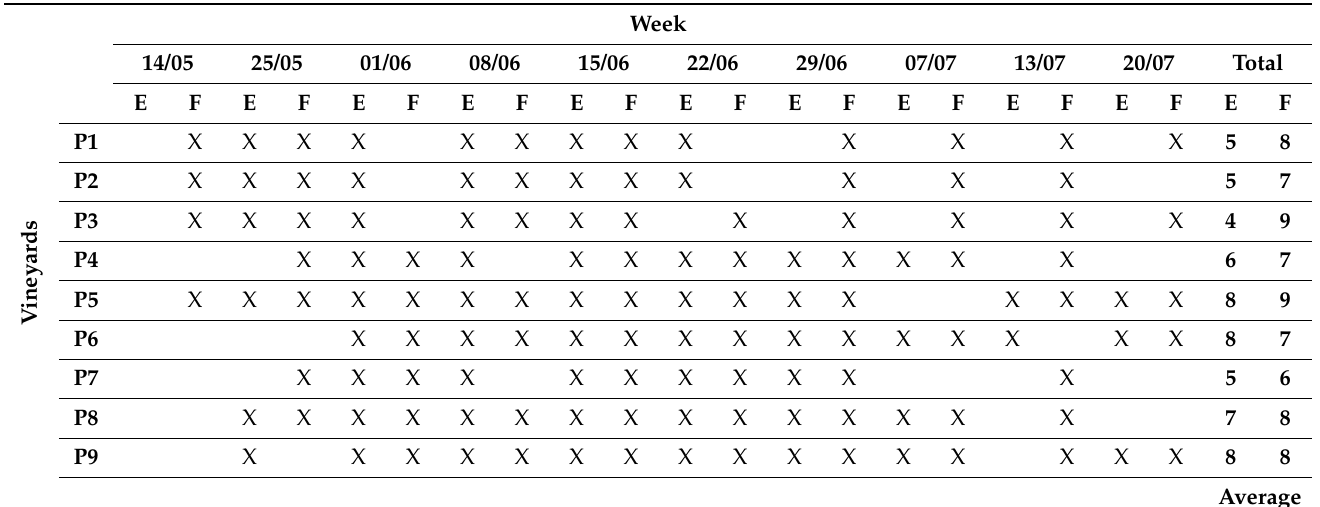
Table 1. Dates of spray applications and total number of treatments performed for downy mildew control in EPI (E) and farmer (F) plots of the nine considered vineyards during 2020. Different letters indicate significant differences among samples ( p < 0.05).